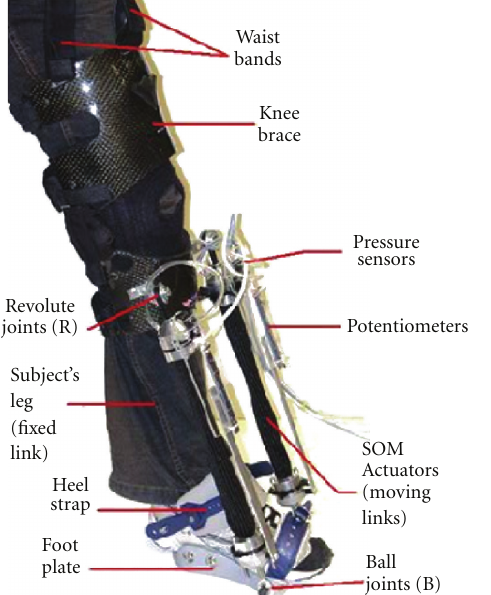
Figure 12: The Robotic Gait Trainer developed in the Human Machine Integration Laboratory at the Arizona State University. which can be either employed as a balance/proprioception trainer or configured to accommodate range of motion and strengthening exercises